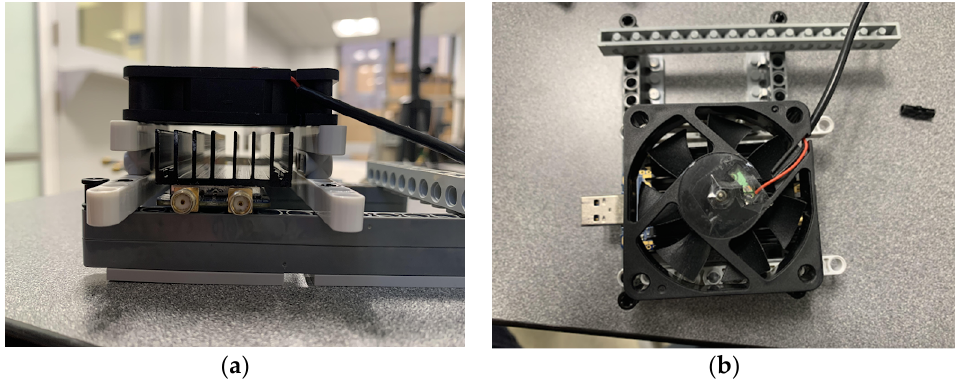
Figure 5. LimeSDR-Mini cooling system: ( a ) side view showing the heatsink and the fan and ( b ) top view showing the fan.